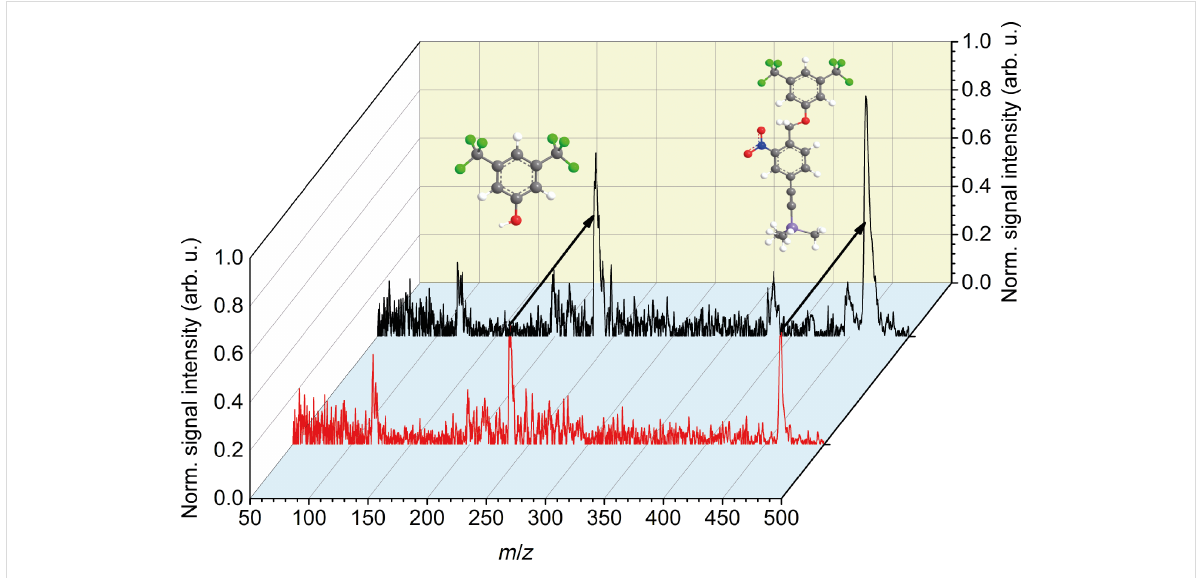
Figure 5: Photodepletion of the photocleavable nitrobenzyl derivative. When the dissociation laser pulse with an energy of 3.7(1) mJ in a beam diameter of 3.3(1) mm preceded the VUV ionization pulse by 600 µs, we observed beam depletion of the neutral parent molecule by a factor of four (red curve). The black spectrum represents the calibration curve without cleavage laser beam.